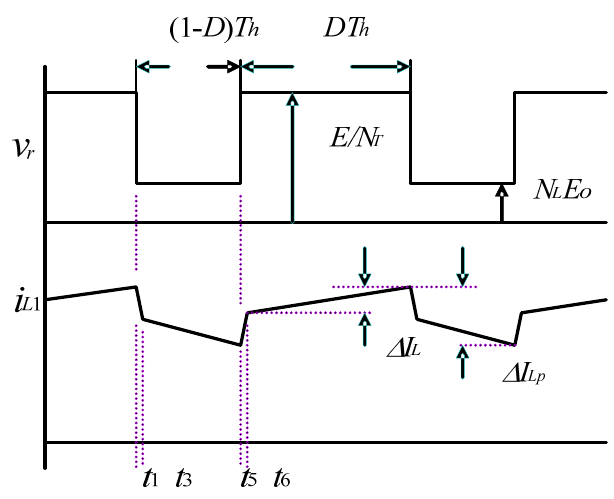
Figure 6. Rectified voltage v r and inductor current i L 1 operational waveforms.